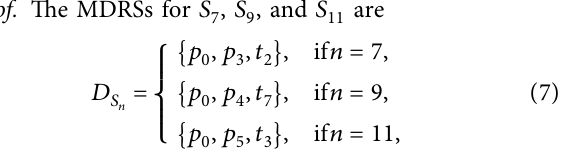
5 shows that the